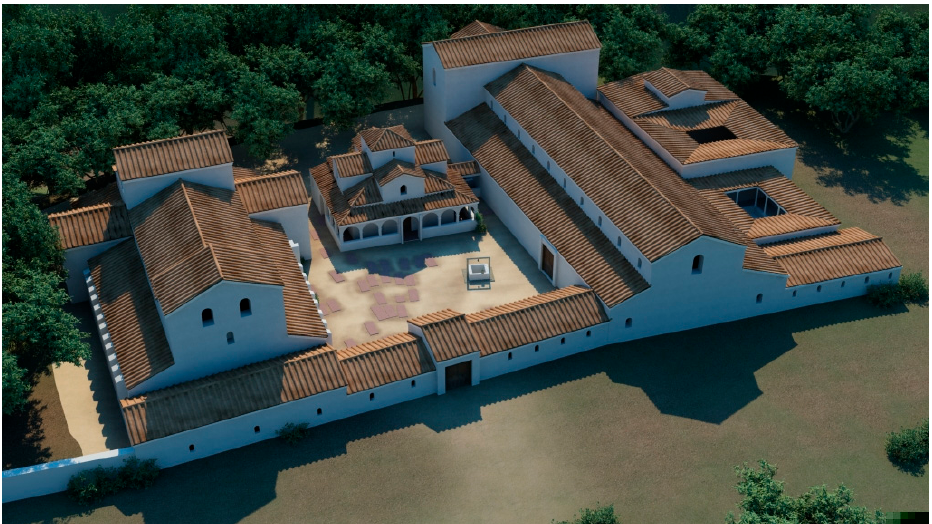
Figure 2. Episcopal See of Egara (Terrassa). Virtual reconstruction. © Dualmultimedia, according to G. Garcia, A. Moro, and F. Tuset (with kind permission).